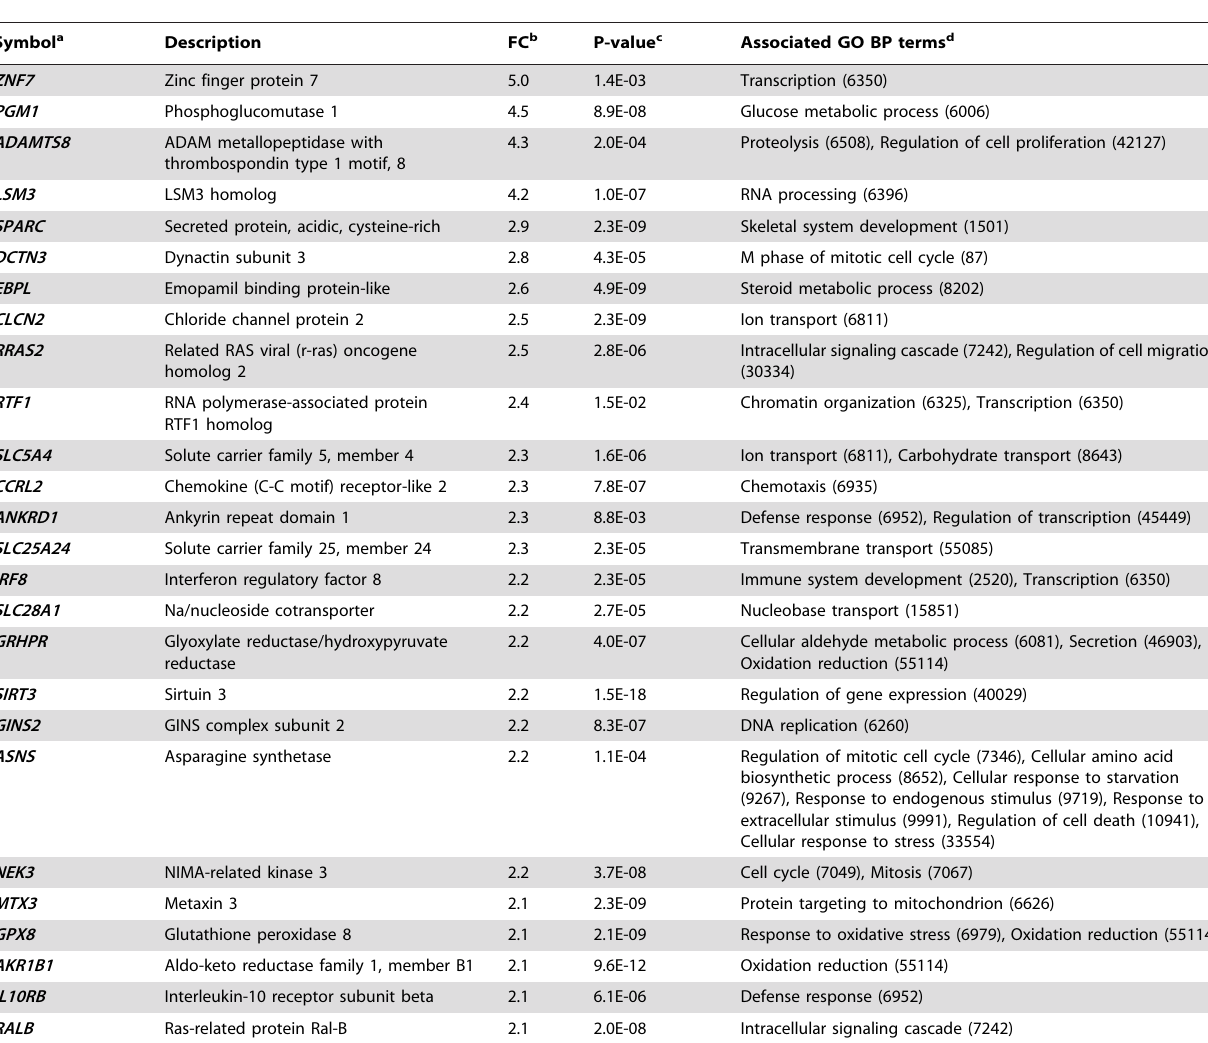
Table 3. Genes highly expressed in the Longissimus muscle of Large White pigs (n=20).